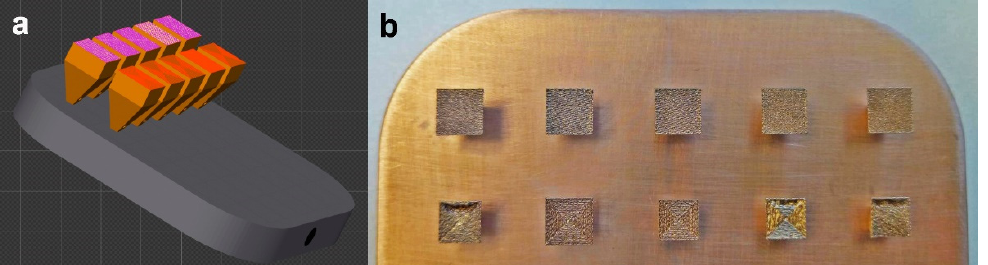
Figure 4. ( a ) Working table of the reduced built volume accessory. ( b ) An example of several samples built with different parameters and scanning strategies.